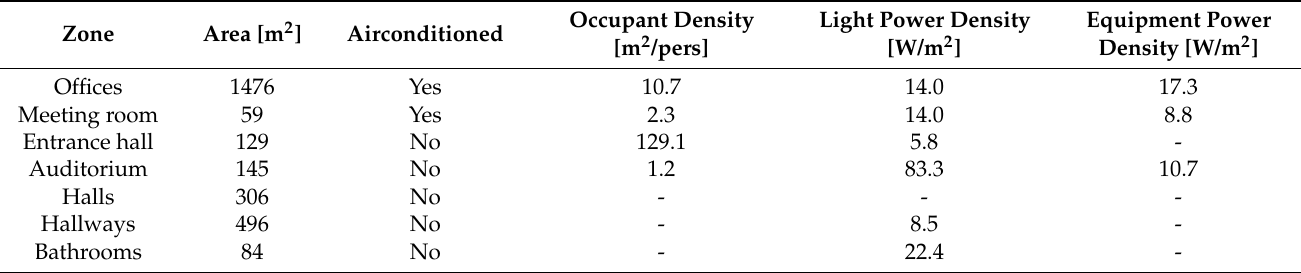
Table 3. Zone areas and air-conditioned